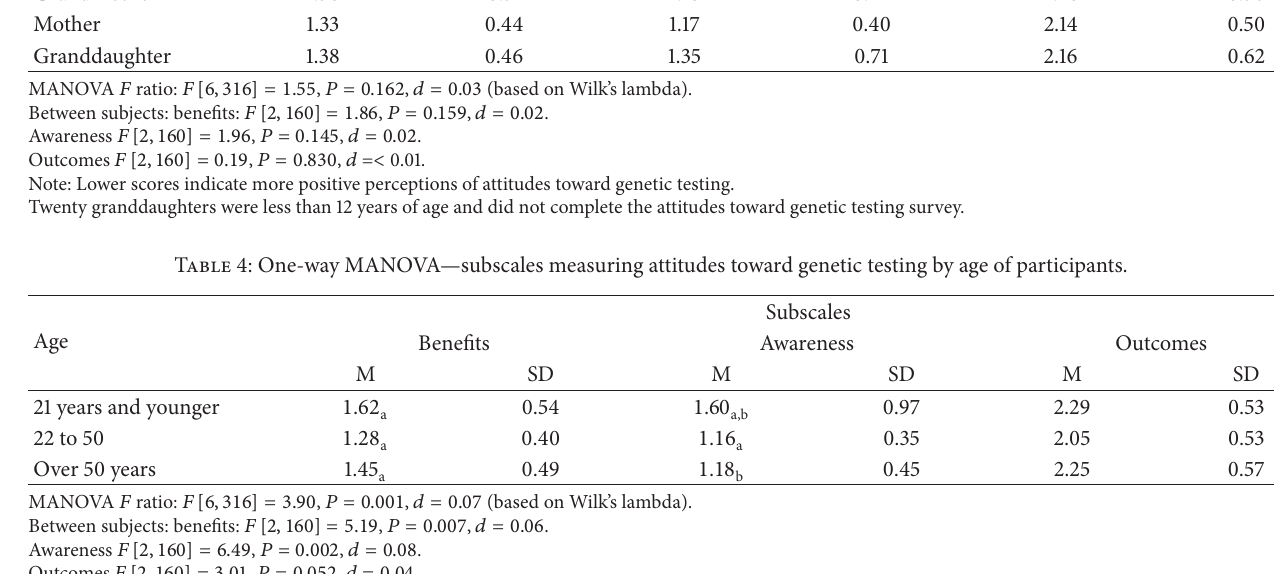
Table 3: One-way MANOVA—subscales measuring attitudes toward genetic testing by triad membership. Subscales Triad Benefits Awareness Outcomes M SD M SD M SD Grandmother 1.50 0.51 1.18 0.44 2.20 0.56 Mother 1.33 0.44 1.17 0.40 2.14 0.50 Granddaughter 1.38 0.46 1.35 0.71 2.16 0.62 MANOVA 𝐹 ratio: 𝐹[6,316] = 1.55 , 𝑃 = 0.162 , 𝑑 = 0.03 (based on Wilk’s lambda). Between subjects: benefits: 𝐹[2,160] = 1.86 , 𝑃 = 0.159 , 𝑑 = 0.02 .